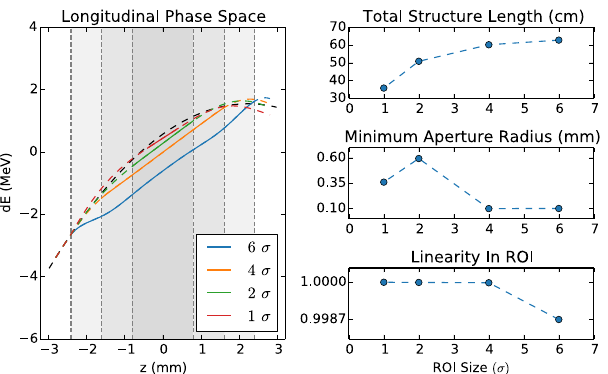
FIG. 7. Left: comparison of LPSS linearization results, depend- ing on the size of a defined region of interest (ROI) within the bunch. The solid part of the lines corresponds to the respective ROI. The black curve corresponds to the initial LPS. Right: total LPSS structure length, minimal segment aperture radius within the structure and linearity of the output LPS within the respective ROI, depending on the ROI size.